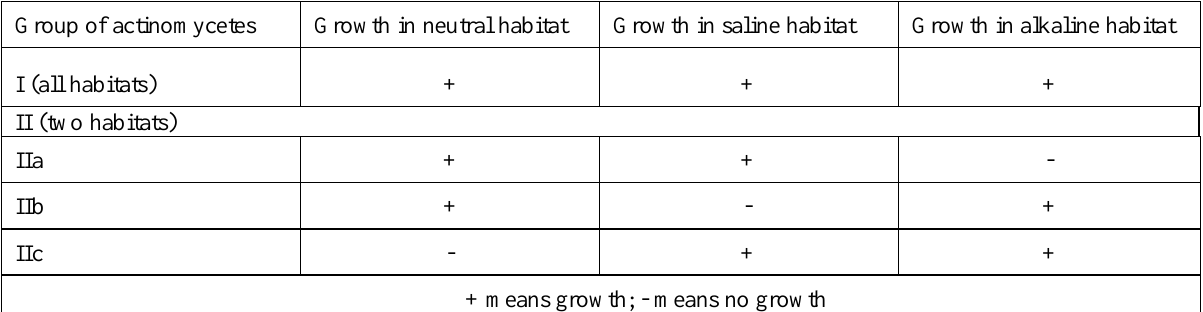
Table 1. Classification of actinomycetes based on their ability to grow under different conditions Group of actinomycetes Growth in neutral habitat Growth in saline habitat Growth in alkaline habitat